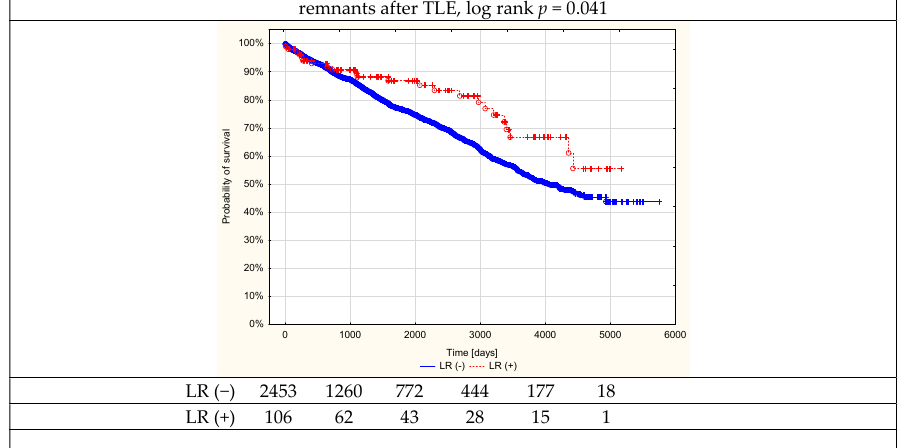
Survival after TLE in patients with infectious indications according to the presence or absence of lead remnants after TLE, log rank p = 0.017